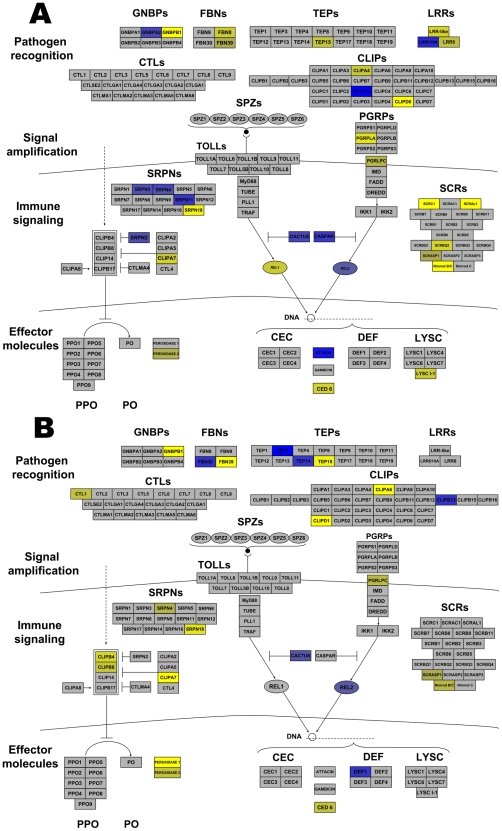

Wolbachia strain-specific regulation of Anopheles gambiae immune pathways.
Anopheles immune networks regulated by wRi (A) and wAlbB (B). Pathways are models of the IMD and Toll pathways [81] and components of the melanization regulatory module [51] divided into the 4 broad categories of immune molecules. Blue color represents induction, while yellow color represents suppression. The intensity of coloring is proportional to the intensity of expression. Regulation is depicted to a maximum fold change of ±4. Some transcripts were greater than ±4 regulated. Abbreviations: LLR leucine rich repeats; FBNs fibrinogens; TEPs thioester containing proteins; GNBPs Gram-negative binding proteins; CTLs C type lectins; CLIPs clip-domain serine protease; PGRPs peptidoglycan recognition proteins; SRPNs serpins; CEC cecropins; Def defensins; PPO Prophenoloxidase; PO phenoloxidase; LYS lysozmyes.